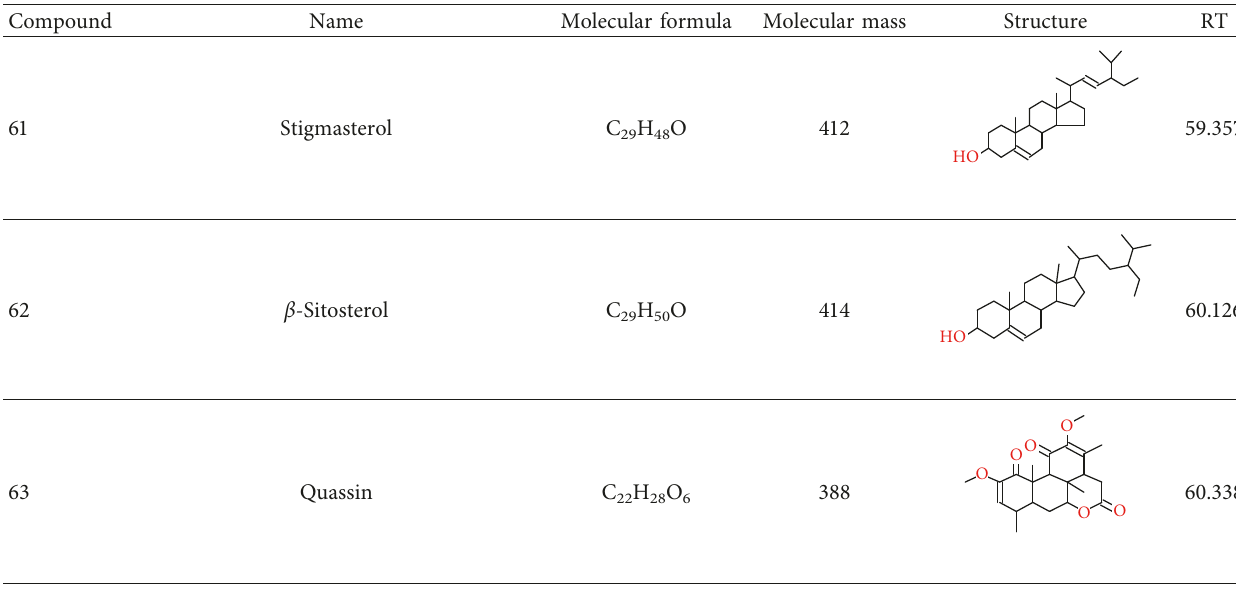
Table 14: Molecular formula, molecular mass, structure, and RT of compounds 61–66 of whole plant n -hexane fraction of Achillea wilhelmsii